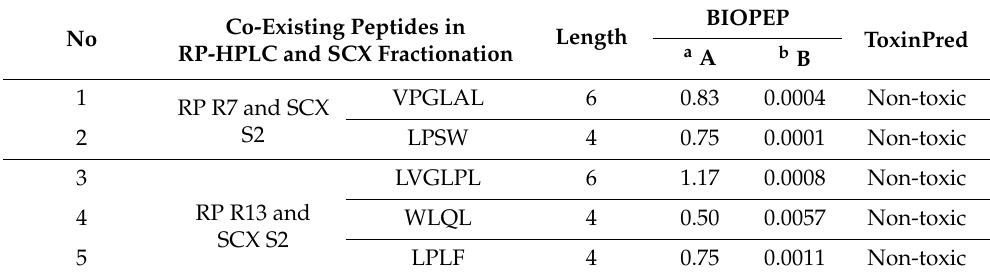
Table 2. In-silico analysis of the five overlapping peptides co-existing in both RP-HPLC and SCX